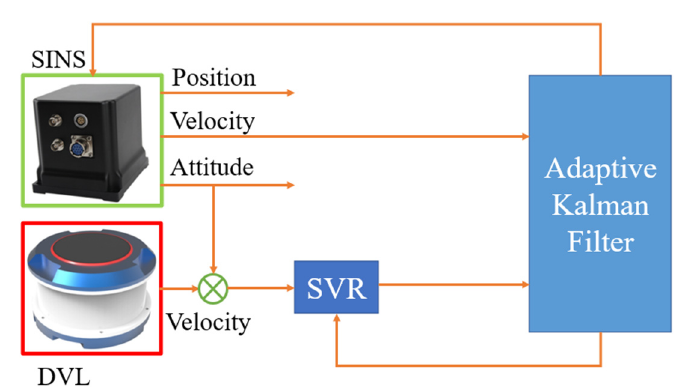
Figure 1. Schematic diagram of SINS/DVL integrated navigation system.